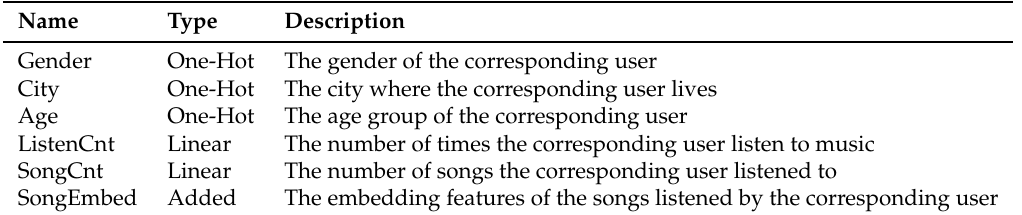
Table 2. The features used in user static preference